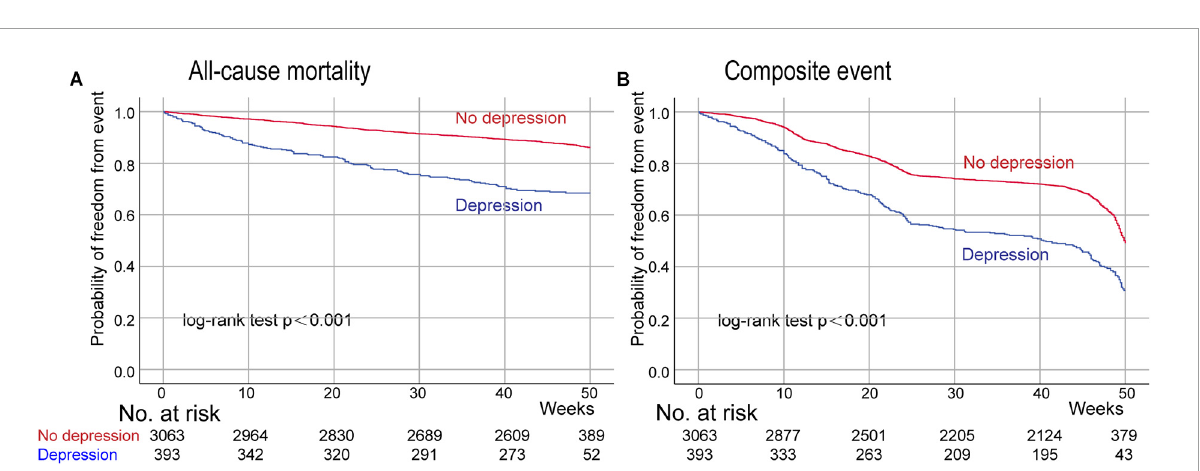
FIGURE3 Kaplan–Meier curves for all-cause mortality and the composite event (death or HF rehospitalization) according to post-discharge depression. Day 0 is the time of the first follow-up after discharge. Panel (A) , the probability of freedom from all-cause mortality; Panel (B) the probability of freedom from the composite of death or HF